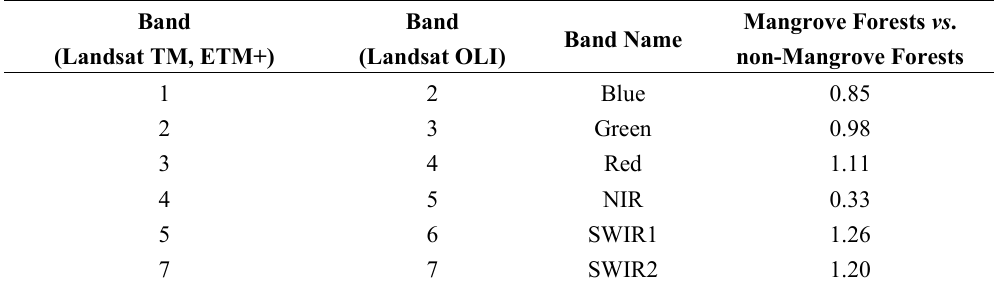
Table 1. The JM distance between mangrove and non-mangrove forests calculated for each Landsat band. Band (Landsat TM, ETM+)